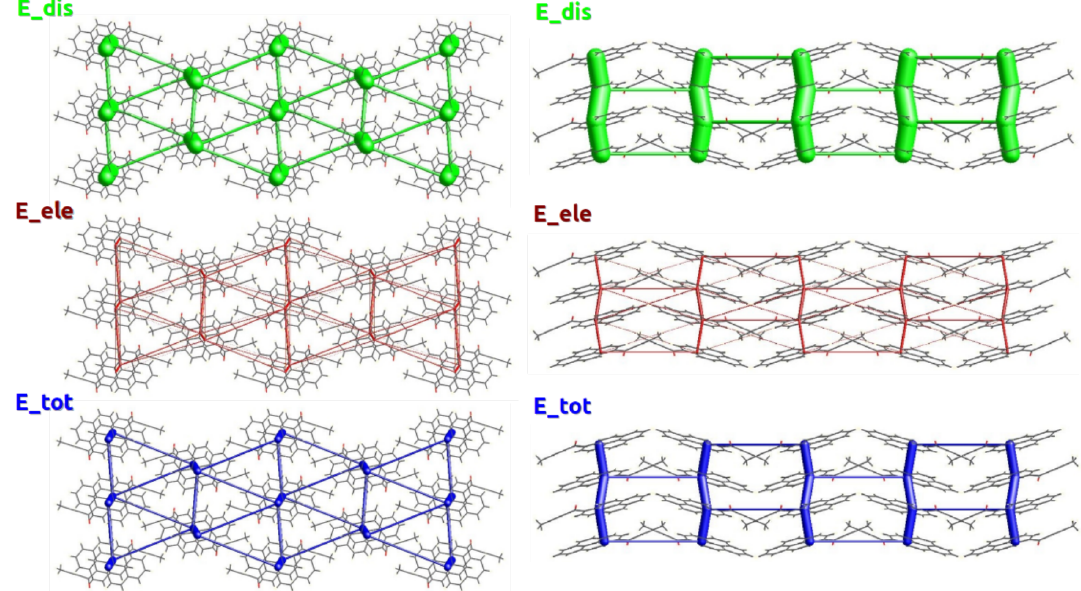
Figure 3. Energy frameworks in the crystal structure of 1a . Green, red, and blue bars represent dispersion, electrostatic, and total interaction energies accordingly. The thickest bars among the total intermolecular interaction energies correspond to energy of − 63.8 kJ/mol and thin bars to energies within the range − 10 to − 12 kJ/mol. Energies with a magnitude less than − 10 kJ/mol have been omitted. Views along the π -stacking direction [100] ( left ) and along [001] ( right